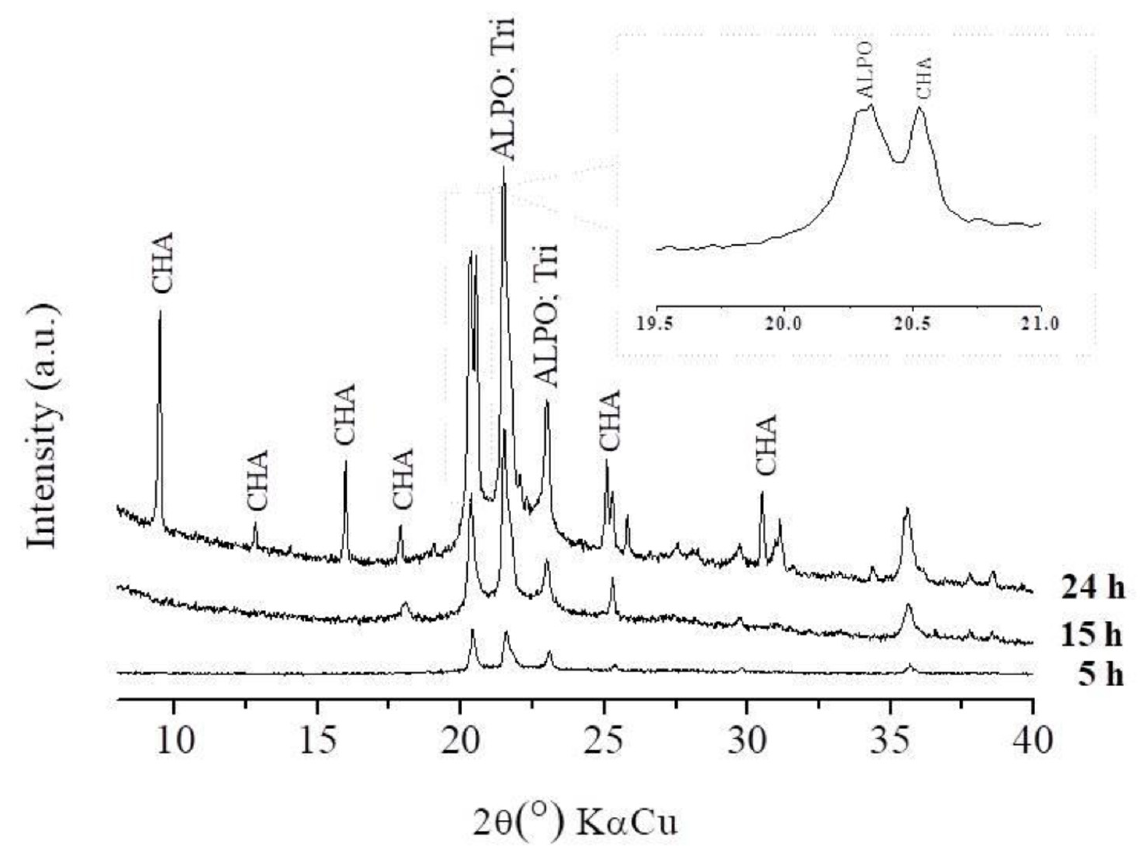
Figure 2. x = 0.5; crystallization time = 5, 15, and 24 h.